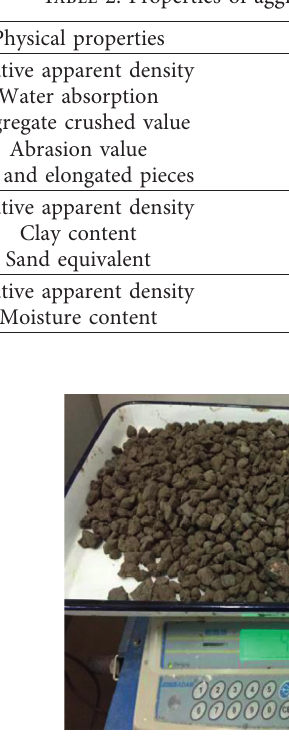
Figure 1: RAP material after drying and sieving. Table 3: Test results of RAP